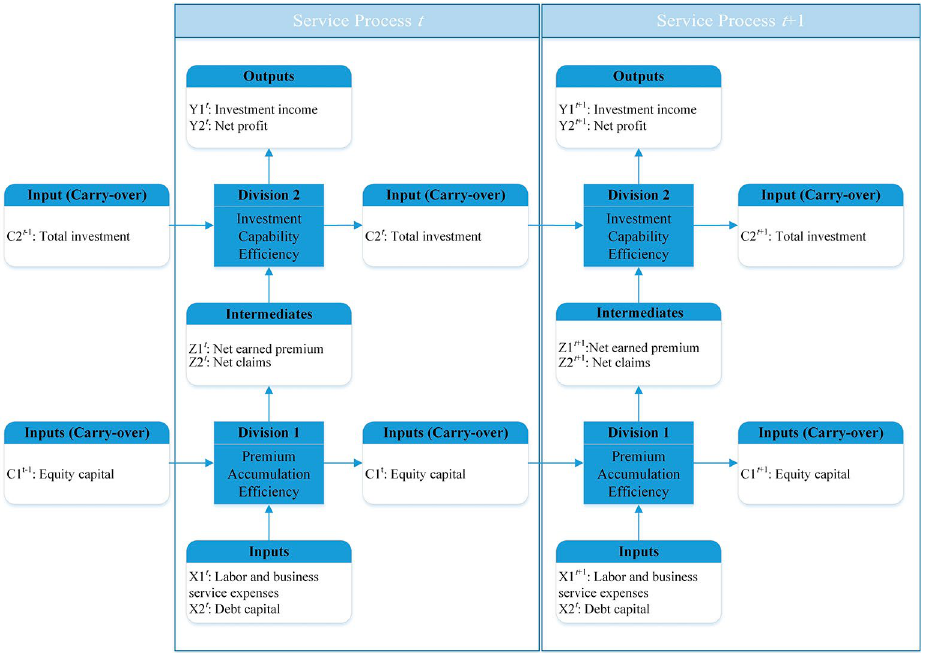
Figure 2. Dynamic network insurance efficiency